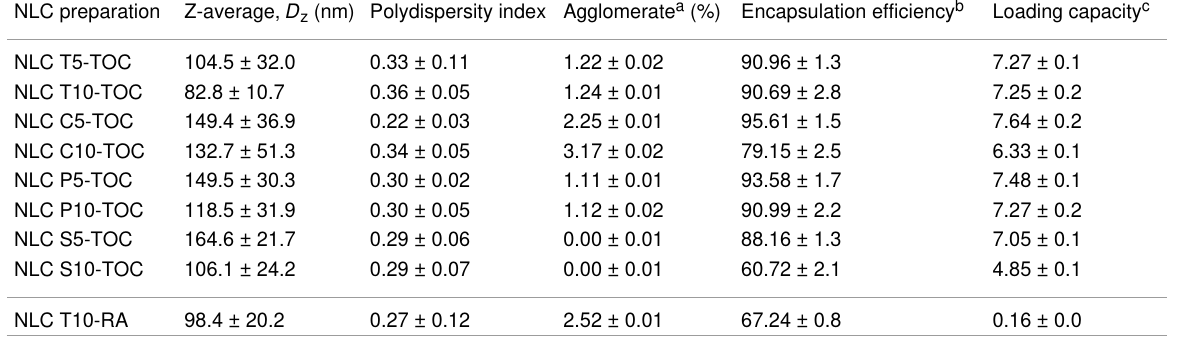
Table 5: Dimensional characteristics, agglomeration and encapsulation parameters of antioxidant-containing NLCs. NLC preparation Z-average, D z (nm) Polydispersity index Agglomerate a (%) Encapsulation efficiency b